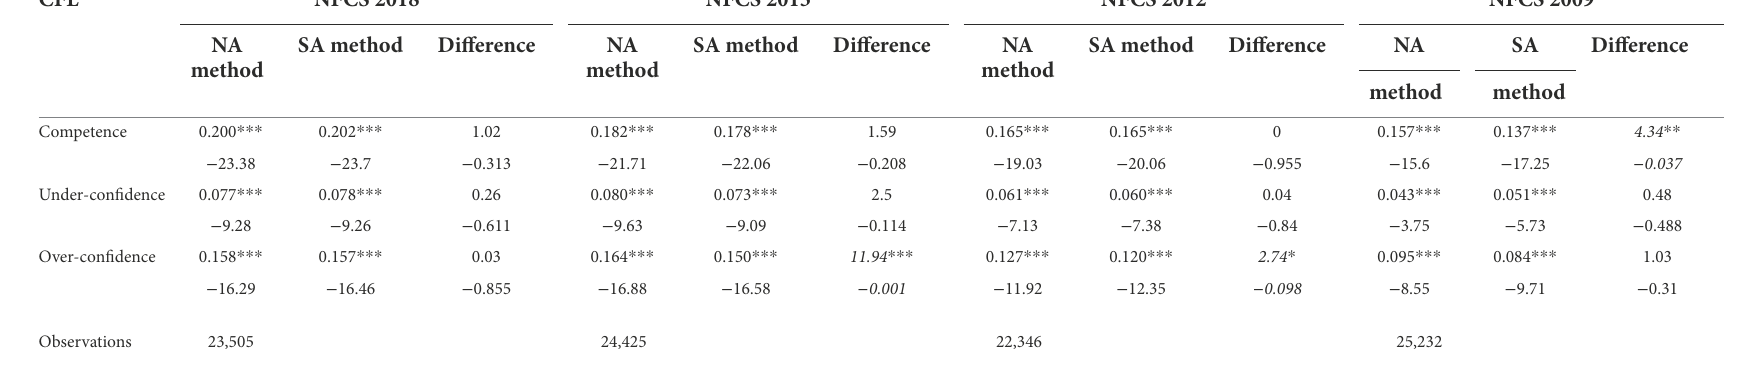
TABLE 9 The marginal effects of the two types of CFL on stock market participation and their differences.